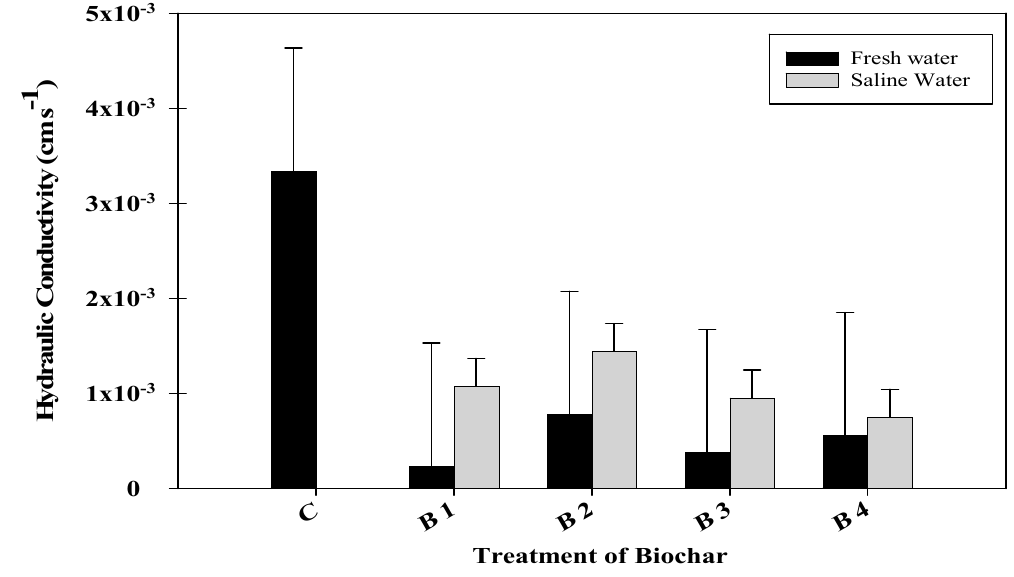
ff ect of biochar application on hydraulic Figure 4. Effect of biochar application on hydraulic conductivity. Figure 4. E